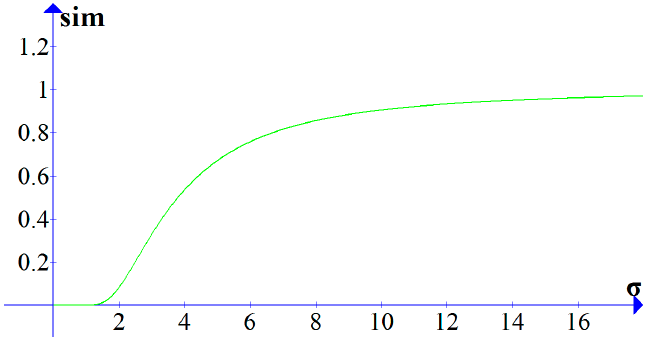
Figure 8. The sensitivity analysis about the value of σ